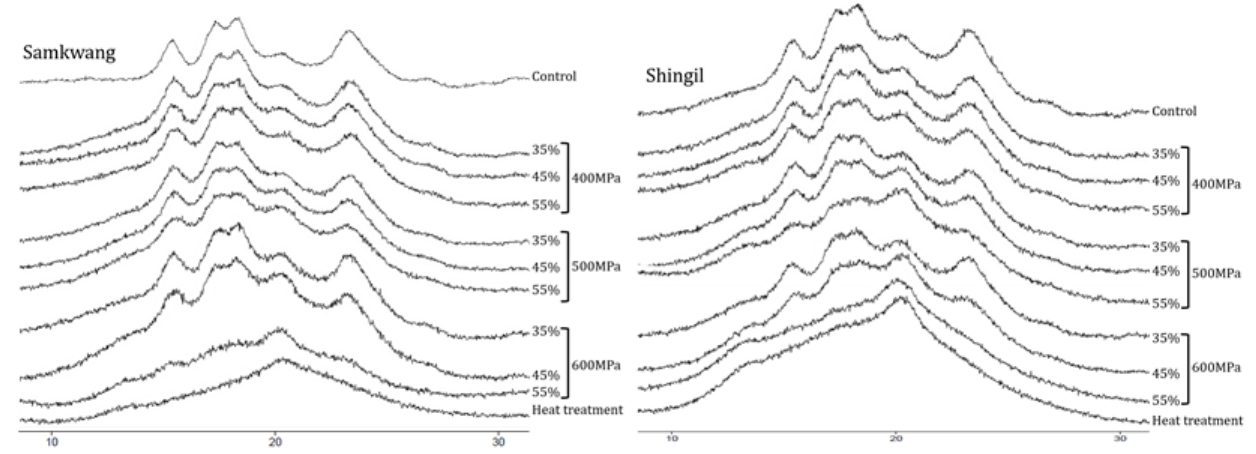
Figure 5. X-ray diffraction pattern of high hydrostatic pressure-treated rice flour at different moisture levels. 35–55%: Moisture content (%), 400–600 MPa: Pressure.